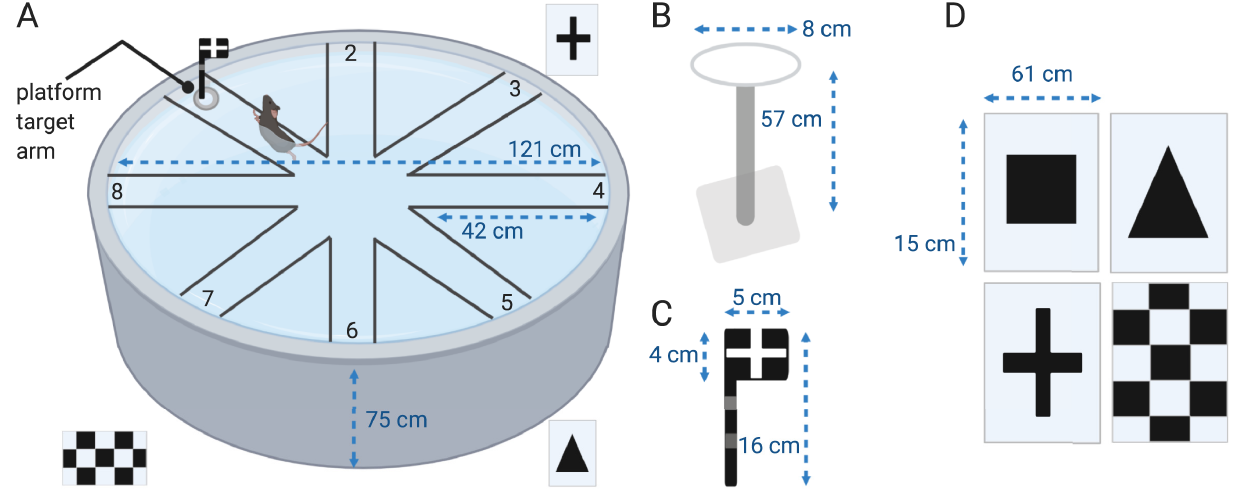
Fig 1. Pool and cues used for RAWM test. (A) RAWM pool is shown with a mouse swimming to reach the visible platform. Four cues (square- not shown in the picture-, triangle, cross and checker board) are equally spaced around pool. (B) Dimensions of platform, (C) flag and (D) cues are reported as